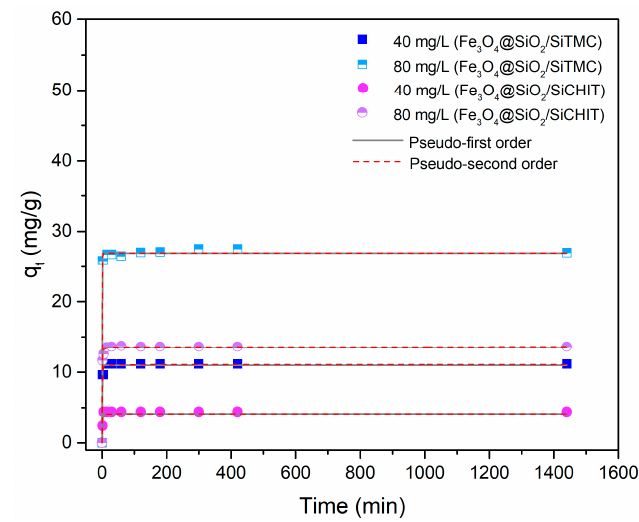
Figure 7. Time profile of adsorption capacity of SMX at variable SMX initial concentration (40 and 80 mg/L) and the corresponding kinetic model fitting using pseudo1 st and pseudo 2 nd order equations.